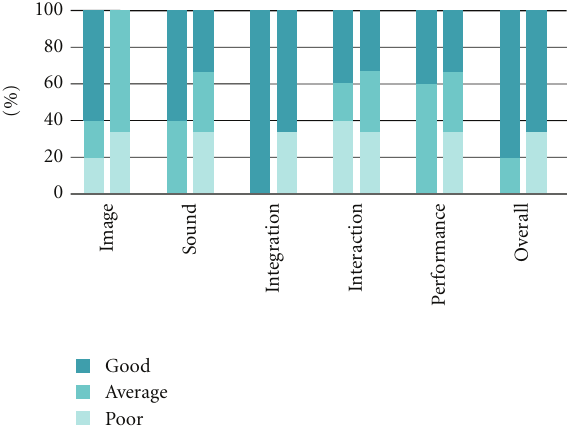
Figure 6: Student ratings for the quality of integrating onsite lectures into a learning platform (left) and a virtual world (right) showed relevant points for further improvement of our